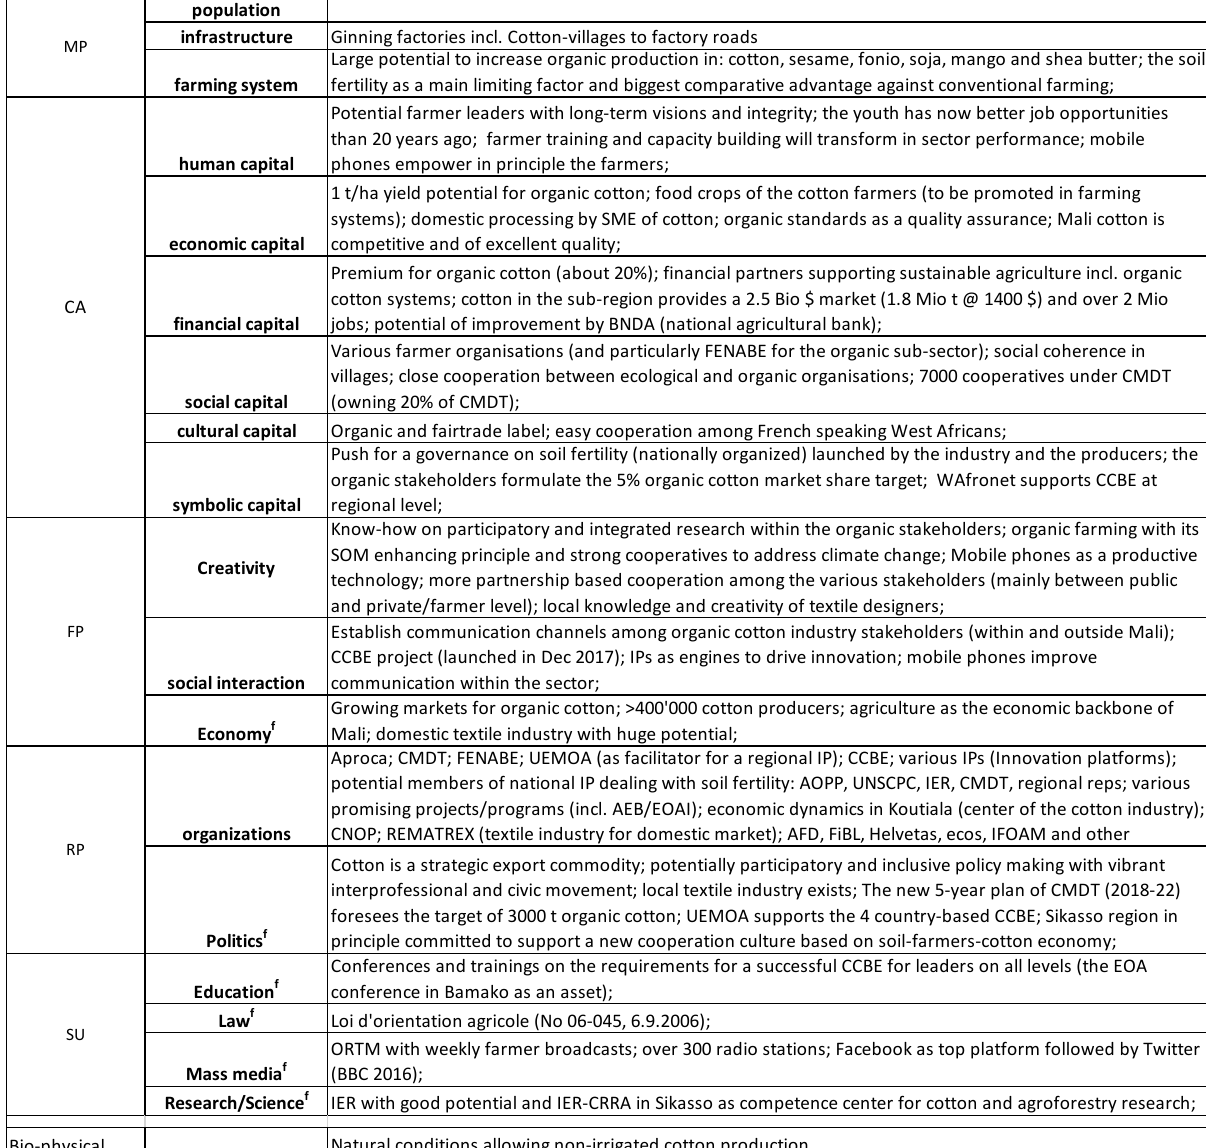
Table 3: Hypothesized asset variables or positive facts based on a first assessment